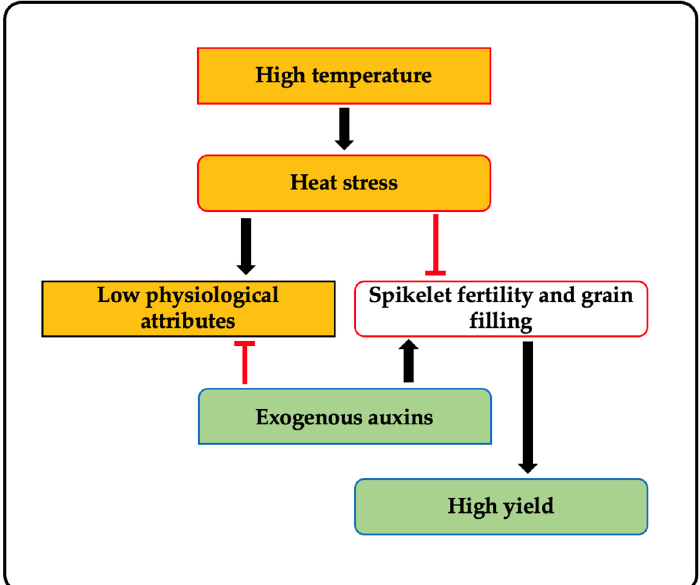
Figure 6. A descriptive model of the effect of auxin application on spikelet fertility and grain filling in rice. The exogenous auxin application obviously alleviated the effects of heat stress, thus influencing physiological attributes and spikelet fertility rate in rice. The pointed black arrow indicates enhancement, while the blunt-ended red arrow indicates decrement.